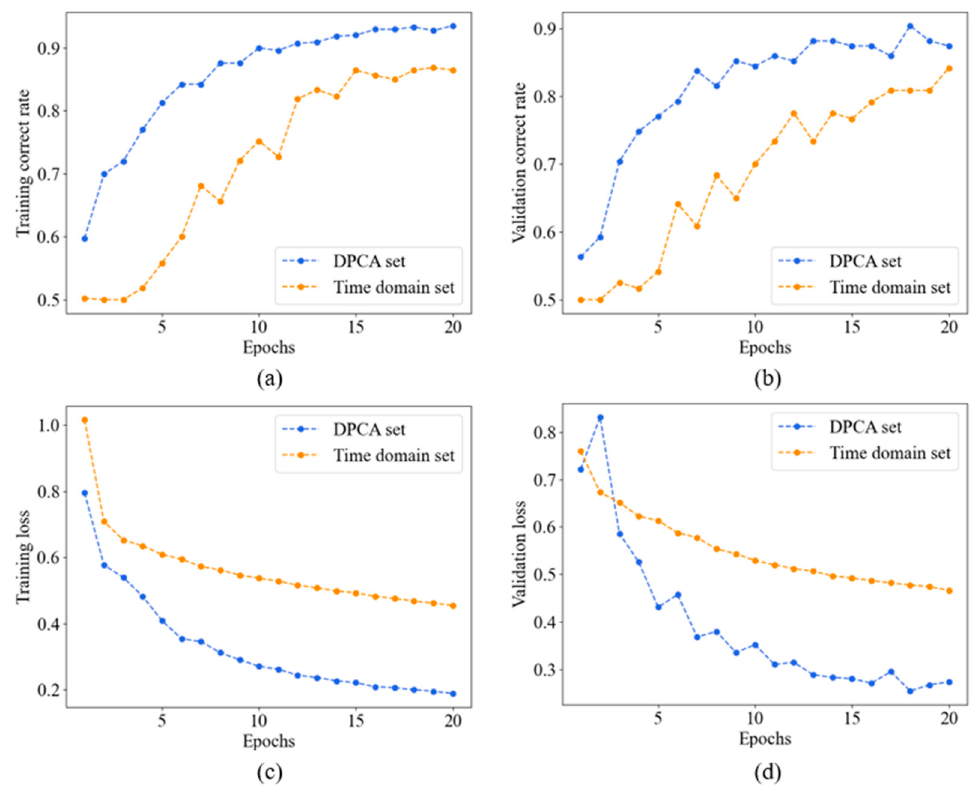
Figure 5. Training and verification results of DPCA sets and time domain sets. ( a ) Training CR, ( b ) validation CR, ( c ) training loss, ( d ) validation loss.